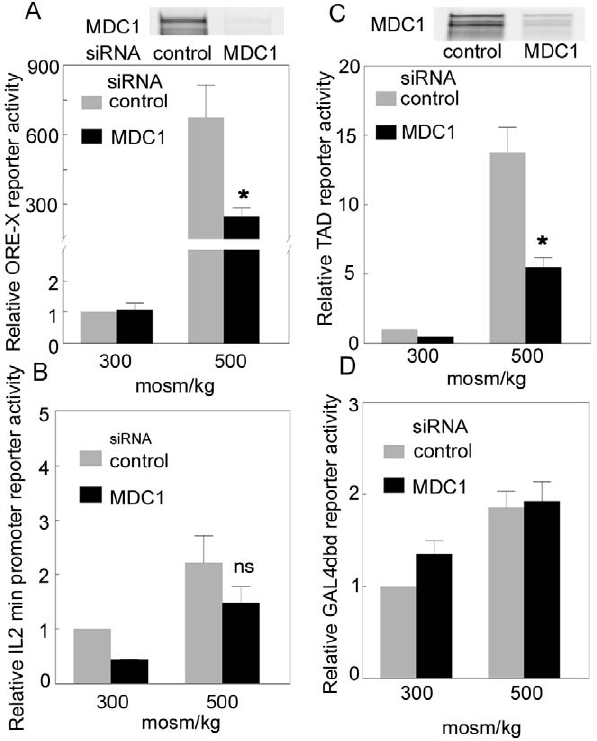
Figure 4. Effect on TonEBP/OREBP transcriptional and trans- activating activities of knocking down MDC1 expression. A. HEK293 cells stably expressing an ORE-X reporter were transiently transfected with 25 nM of siRNA against MDC1 or control siRNA for 48 hours. Then, the osmolality of medium was changed to 500 mosm/ kg by adding NaCl or kept at 300 mosmol/kg, and reporter activity was measured 24 h later. Knock down of MDC1 is shown in the upper panel. ORE-X reporter activity is relative to ‘‘control’’ at 300 mosmol/kg. B. Control for specificity for ORE. Same as (A) except using an IL2 min reporter (no ORE-X DNA element). C. Same as (A) except using HEK293 stably expressing the binary GAL4dbd TAD reporter and measuring luciferase activity 16 hours after adjusting osmolality. D. Control for specificity for TonEBP/OREBP TAD. Same as (C) except using HEK293 cells stably transfected with Gal4 DBD (no TAD). Mean 6 SEM, *, P , 0.01, n=3.